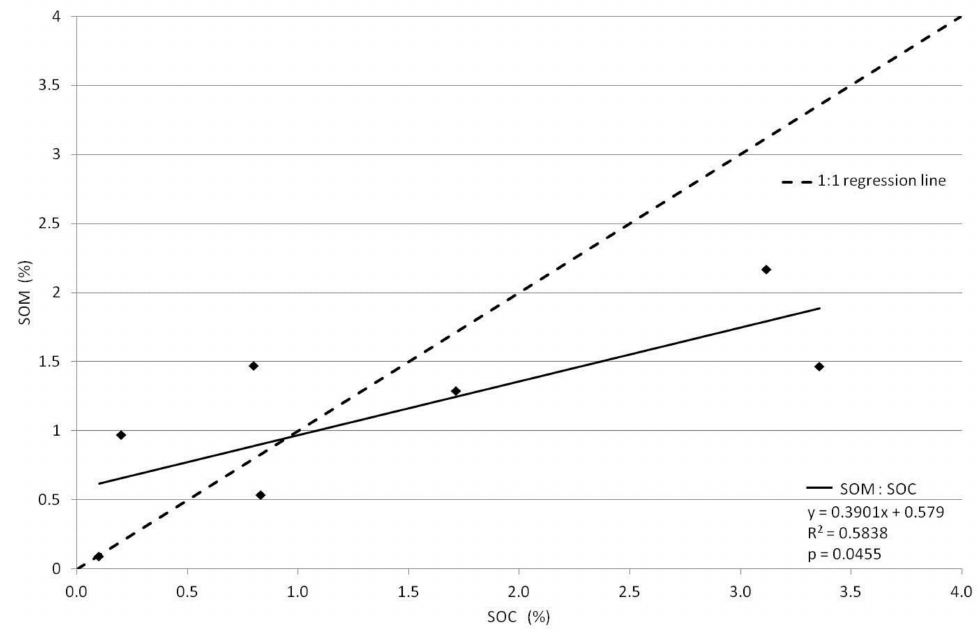
Figure 5. Correlation of SOC (LECO analysis) and SOM (thermogravimetric analysis), compared to a 1:1 reference